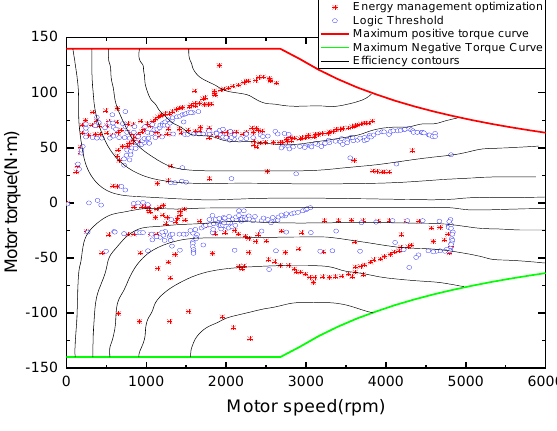
Figure 19. Motor operating point.